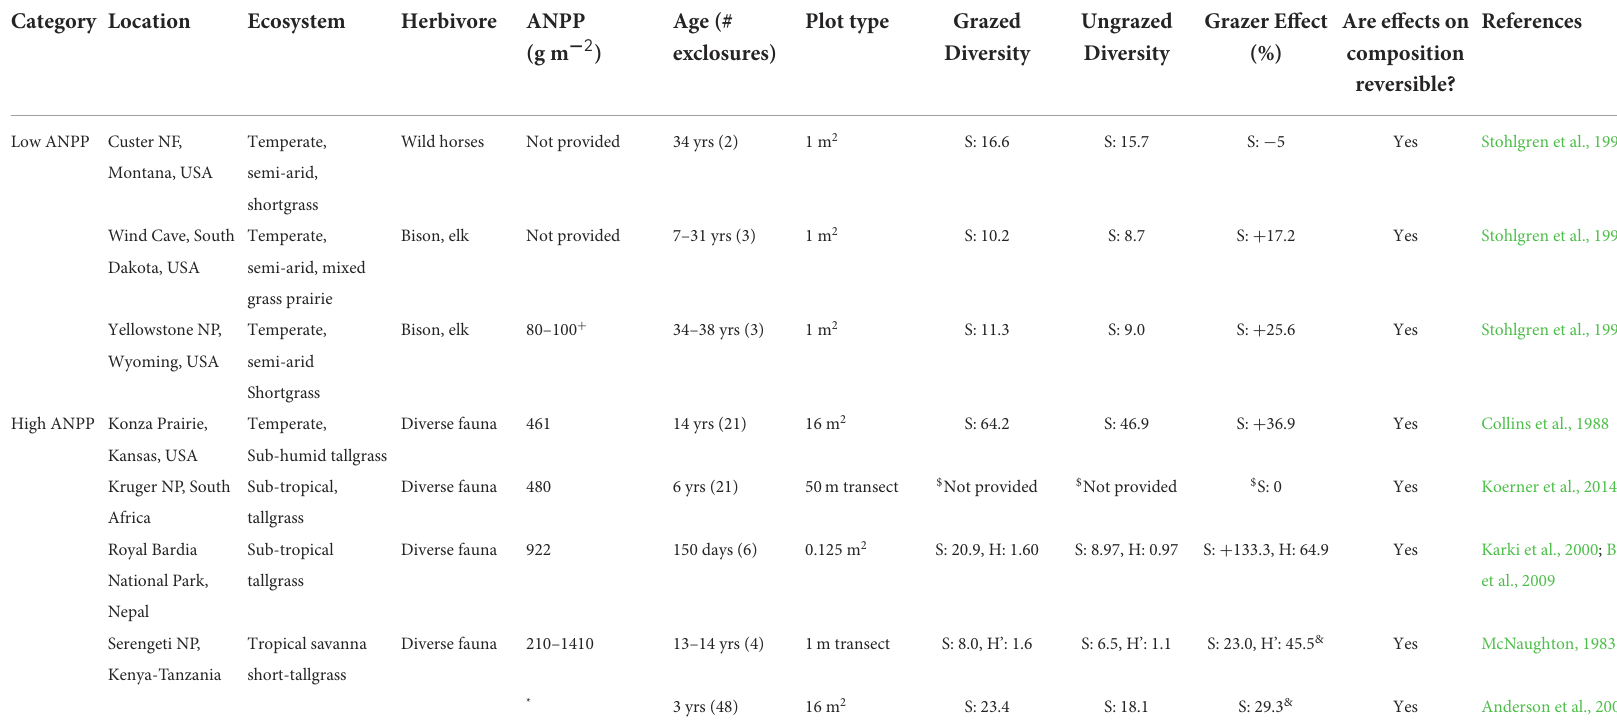
TABLE 2 The characteristics of grassland ecosystems that support abundant herds of migratory wild ungulates where exclosure studies measured the effects of herbivory on species diversity and the resiliency (i.e., reversibility) of grassland species composition to grazing. Category Location Ecosystem